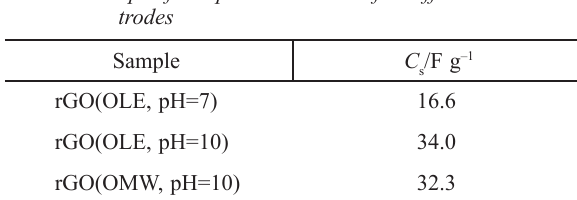
Table 2 – Specific capacitance values for different rGO elec- trodes